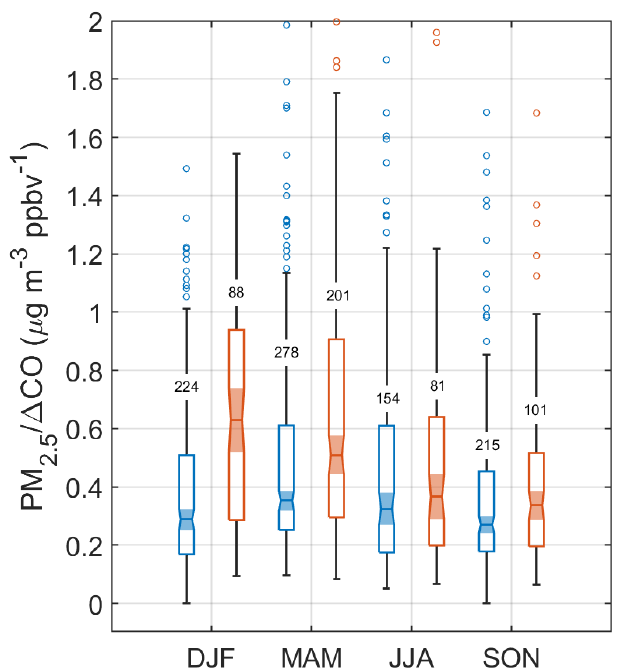
Figure 6. Box notch plot for each season comparing the PM 2 . 5 /(cid:49) CO ratio for Cluster 1 trajectories for high-APT (blue) and low-APT (orange) conditions. APT thresholds are based on 25th ( < 0.9mm) and 75th ( > 13.5mm) percentiles of APT for all trajec- tories reaching Bermuda between 1 January 2015 and 31 December 2019. The number of samples in each group is placed on whiskers.